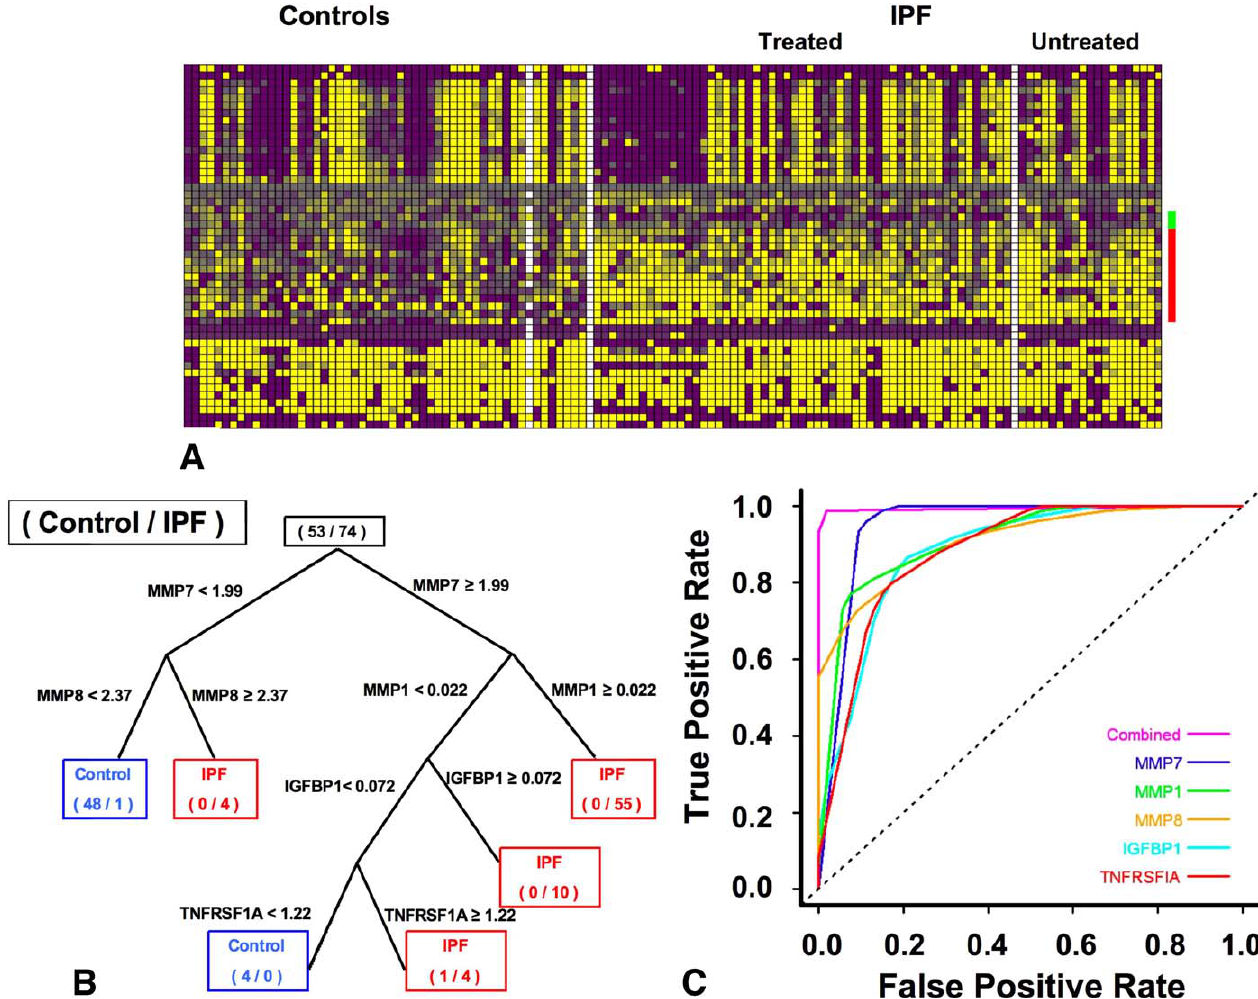
Figure 1. Peripheral Blood Proteins Distinguish IPF Patients from Controls (A) Heatmap of proteins measured in the plasma of IPF and control patients. Columns, individual patients; rows, proteins. Every protein level was divided by the geometric mean of values for the same proteins for all patients and log based 2 transformed. Increasing shades of yellow, increased; increased shades of purple, decreased; gray, unchanged. Proteins were clustered using Genomica. Red vertical line, cluster of proteins increased in IPF; green vertical line, cluster of proteins decreased in IPF. (B) Classification tree obtained by CART applied to plasma protein concentration data from IPF patients and controls. A blue box identifies a terminal node as control; a red box as IPF. All counts are listed as control/IPF. Concentrations are in ng/ml. In the subgroup with high MMP7 concentration but low MMP1 concentration (14 IPF samples, five control samples), splitting on IGFBP1 and TNFRSF1A improves classification, while in the subgroup with low MMP7, MMP8 improves classification. (C) ROC curves for using each of five markers, or their combination, to classify samples as IPF or control. Sensitivity, or true positive rate, is plotted on the y -axis, and false positive rate, or 1 (cid:2) specificity, on the x -axis. The area under each ROC curve is equivalent to the numerator of the Mann-Whitney U - statistic comparing the marker distributions between IPF and control samples. The magenta line labeled ‘‘ Combined ’’ is for the combinatorial classifier using all five markers. The identity line at 45 8 represents a marker that performed no better than classifying samples as IPF or control by flipping a fair coin.